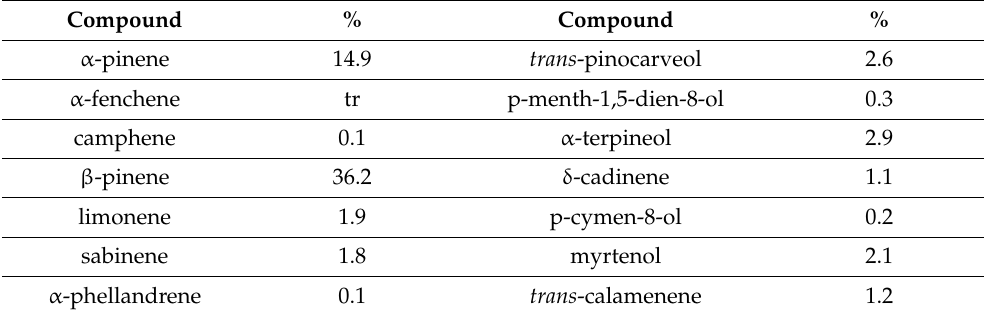
Table 6. Compounds identified in the leaf oil of Backhousia enata